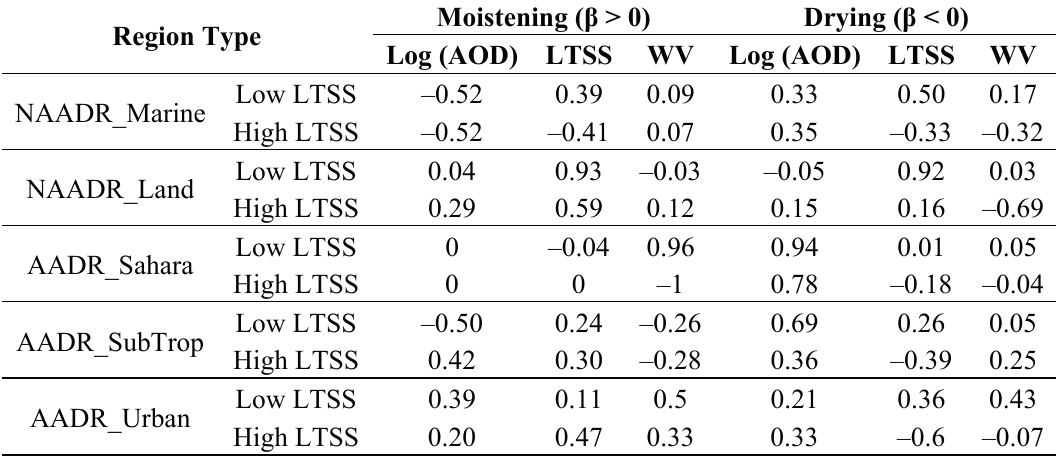
Figure 18. Linear relationship between aerosol optical depth (AOD) and Precipitable Water (PW) for NAADR_Marine, NAADR_Land and AADR_SubTrop. Ridge regression method is applicable for these three sites. Table 12. Summary of the influences of all three variables on cloud water path (CWP) expressed as fraction the total influence (magnitudes of regression coefficients) during both moistening ( β > 0) and drying ( β < 0) and for each type of aerosol. Here it is assumed that the sum of the individual influence is equal to